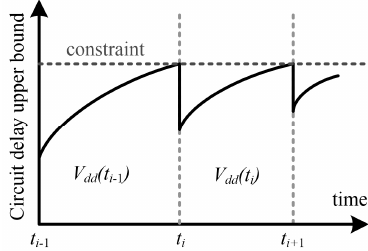
Figure 3. The basic principle of supply voltage assignment.